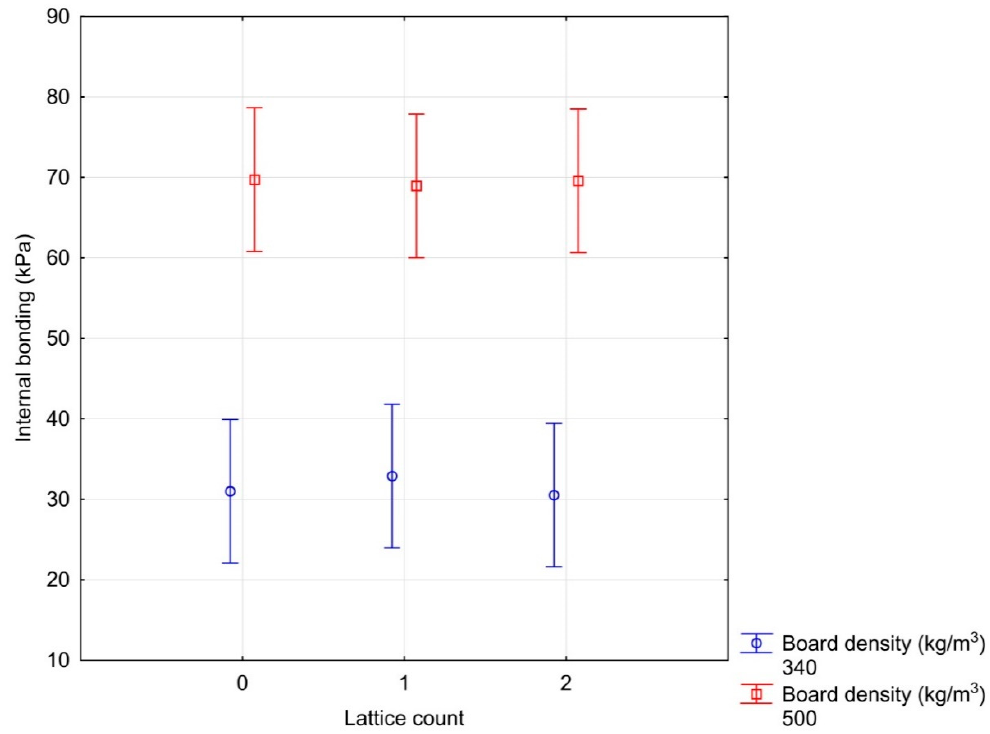
Figure 5. Influence of particleboard density and the number of lattices on the internal bonding of composite materials.